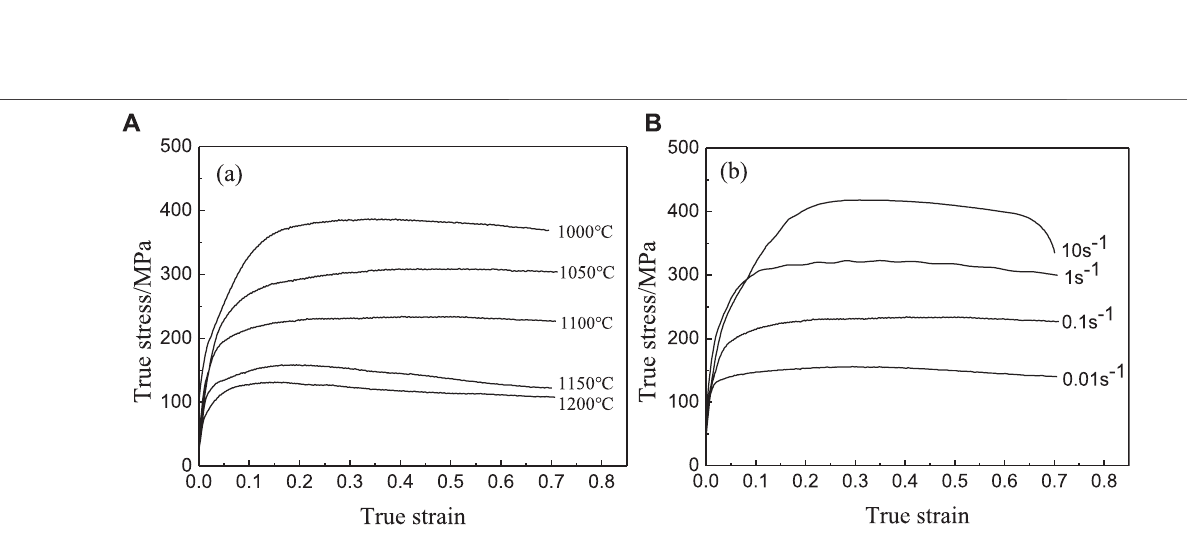
Frontiers in Materials |